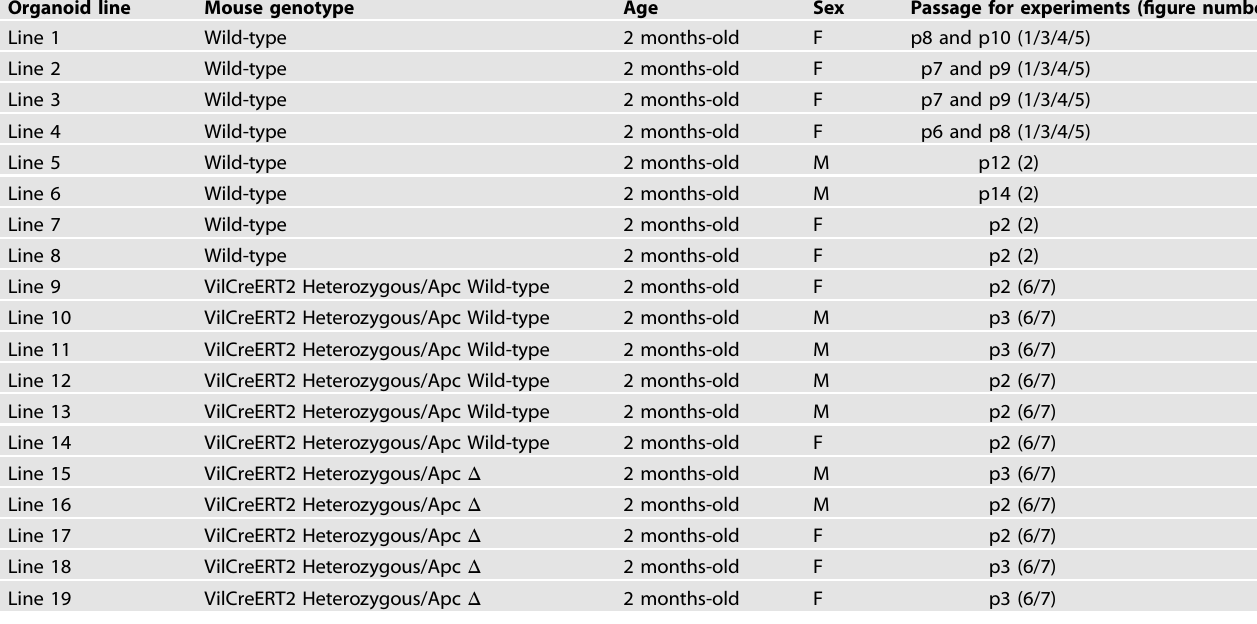
Table 1. List of organoid lines used. Organoid line